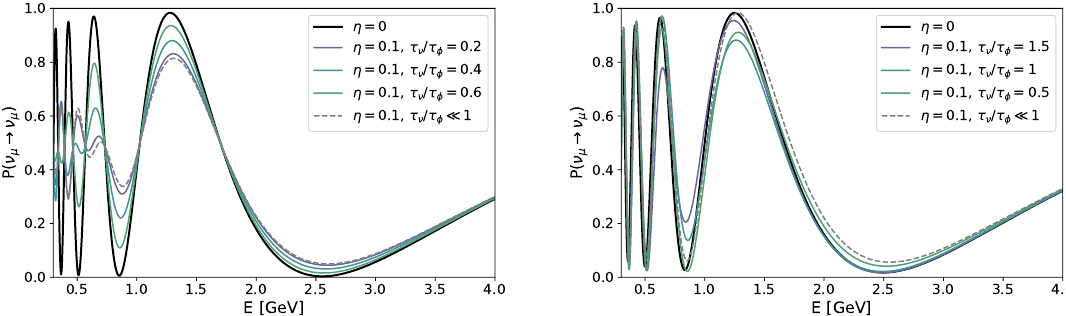
(left) and θ 23 (right) 31